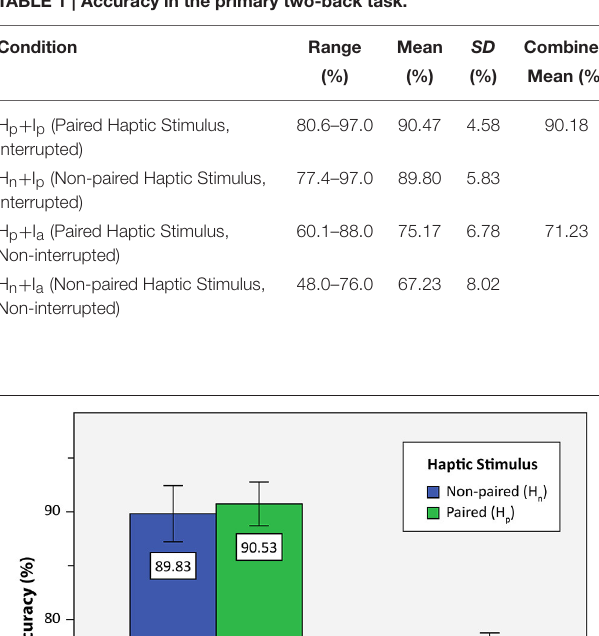
TABLE 1 | Accuracy in the primary two-back task.